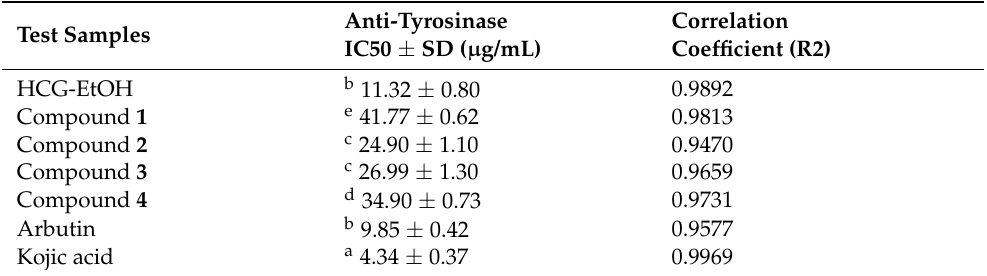
Table 3. Tyrosinase inhibitory activity of different extracts and compounds from Harpephyllum caffrum (HCG-EtOH) compared with the positive control: arbutin and kojic